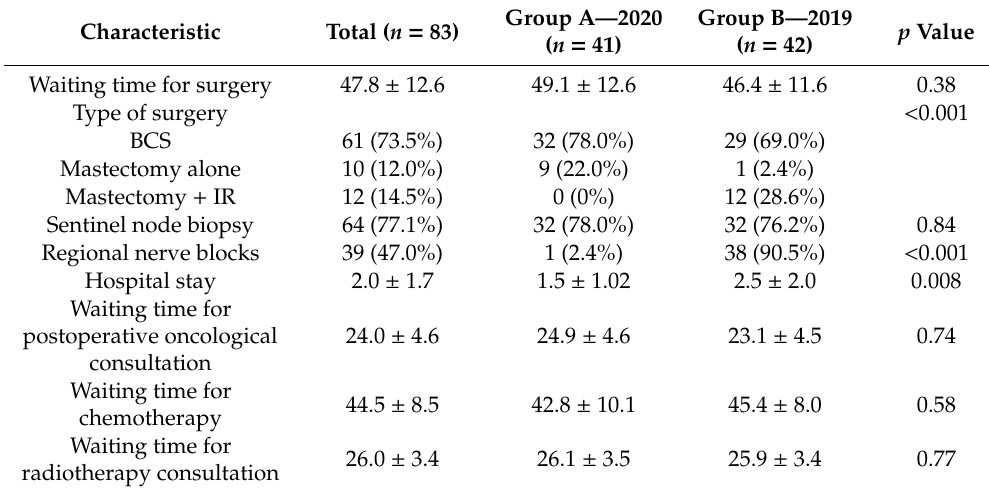
Table 2. Surgical and management outcomes of the study